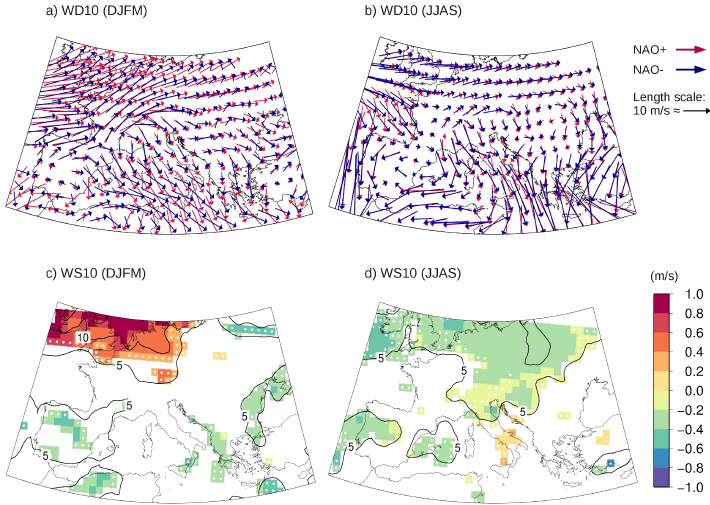
Fig. 3. NAO impact in winter (left) and summer (right) on atmospheric conditions. (a, b) depict mean 10m wind direction during NAO + (red) and NAO − (blue) phases (the arrow’s length is proportional to the wind speed). (c, d) provide the NAO + minus NAO − composites for the mean 10m wind module (in ms − 1 ). These differences are represented only if they meet the significativity criteria exposed in Sect. 3, dots blur the values not representing a signal-to-noise ratio above 1, and contours depict differences expressed as percentage. Period considered: